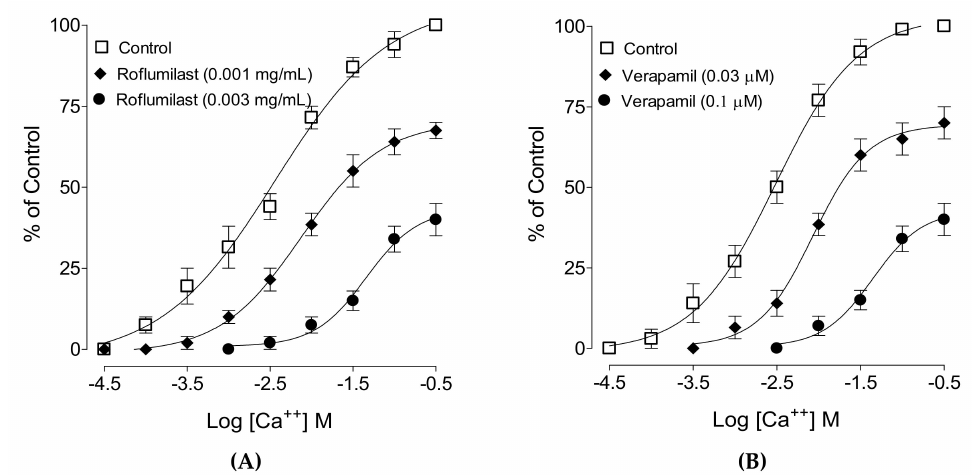
Figure 2. Concentration–response curves of Ca ++ in the absence and presence of increasing concentrations of ( A ) roflumilast and ( B ) verapamil in isolated rabbit jejunum preparations. Values shown are mean ± SEM, n =